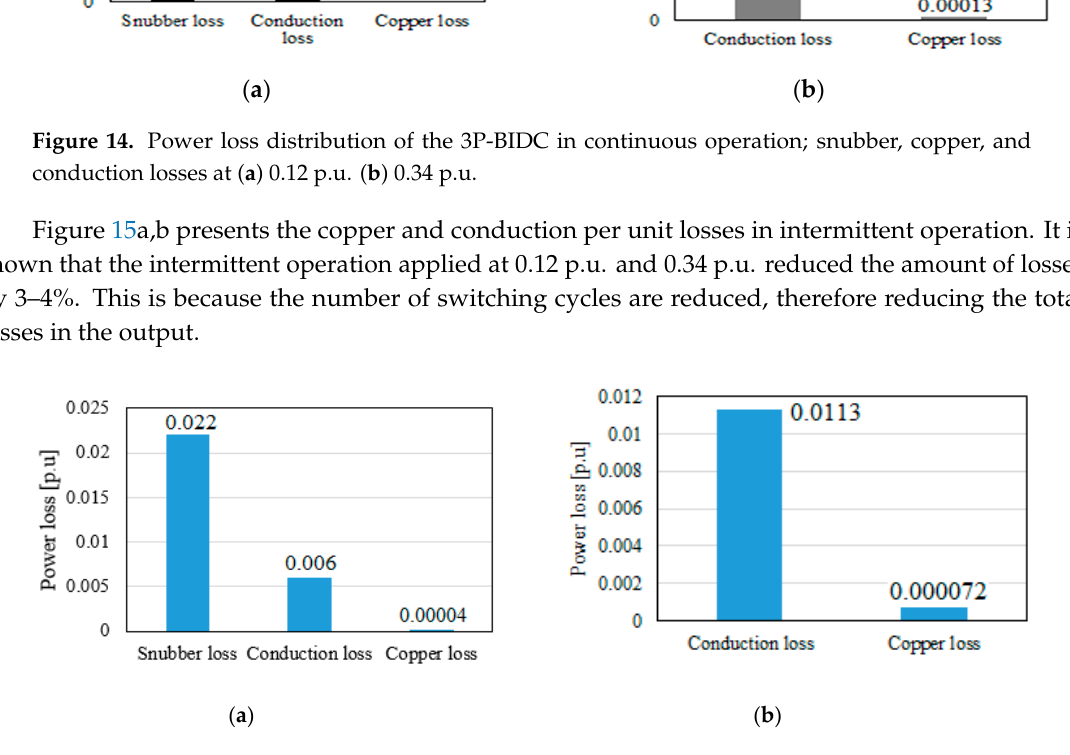
Figure 15. Power loss distribution of the 3P-BIDC in intermittent operation; copper loss and conduction loss at ( a ) 0.12 p.u. ( b ) 0.34 p.u.